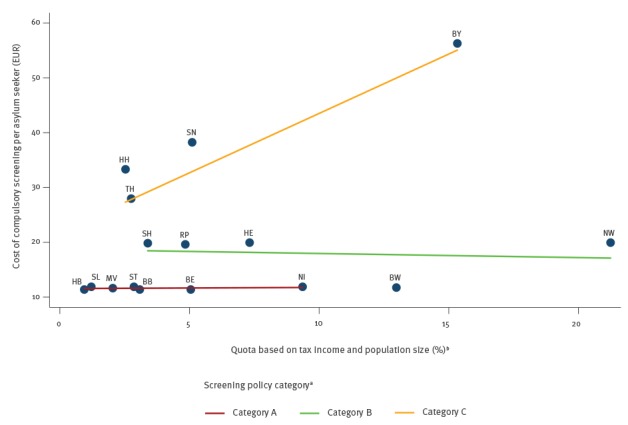
Scatter plot of estimated per capita costs of medical screening of asylum seekers by the socioeconomic strength of federal states and category of screening policy, Germany, 2015 (n = 441,899 first-time applicant asylum seekers)